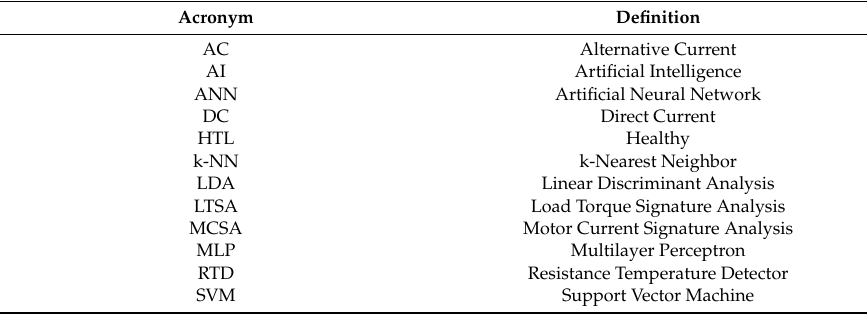
Table 1. Acronyms and